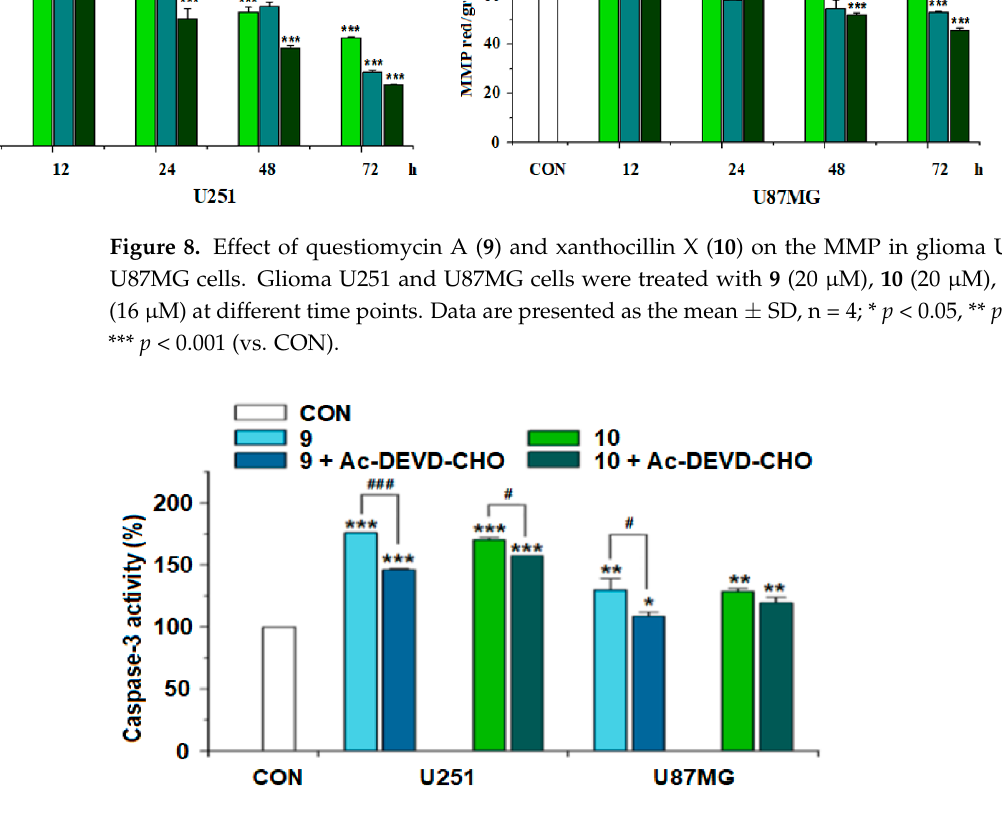
Figure 9. Effect of questiomycin A ( 9 ) and xanthocillin X ( 10 ) on the caspase-3 activity in glioma U251 and U87MG cells. Glioma U251 and U87MG cells were treated with 9 (20 µ M), 10 (20 µ M), 9 (20 µ M) + Ac-DEVD-CHO (10 µ M), and 10 (20 µ M) + Ac-DEVD-CHO (10 µ M) for 24 h. Data are presented as the mean ± SD, n = 4; * p < 0.05, ** p < 0.01 or *** p < 0.001 (vs. CON); # p < 0.05 or ### p < 0.001 ( 9 + Ac-DEVD-CHO or 10 + Ac-DEVD-CHO vs. 9 or 10 ).